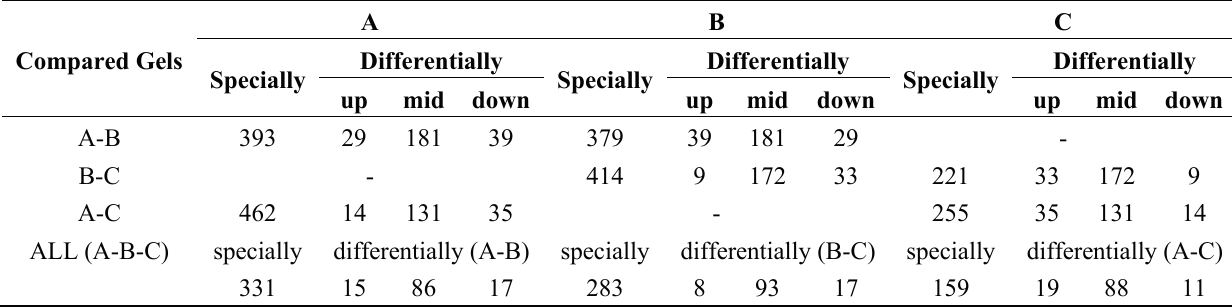
Table 1. Protein spots expressed differentially and specially in non-browned explants without somatic embryos (NBNSE, A), browned explants with somatic embryos (BSE, B), and browned explants without somatic embryos (BNSE, C) during somatic embryogenesis of Fraxinus mandshurica